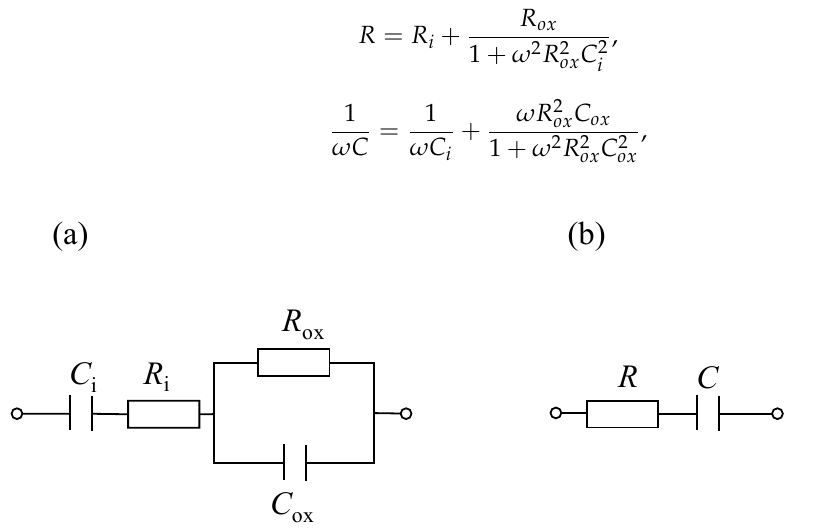
Figure 6. ( a ) Equivalent circuit depicting the interface impedance ( C i , R i ) in series with the oxide capacitance ( C ox , R ox ). ( b ) Total observed capacitance C and resistance R in terms of an equivalent series circuit.